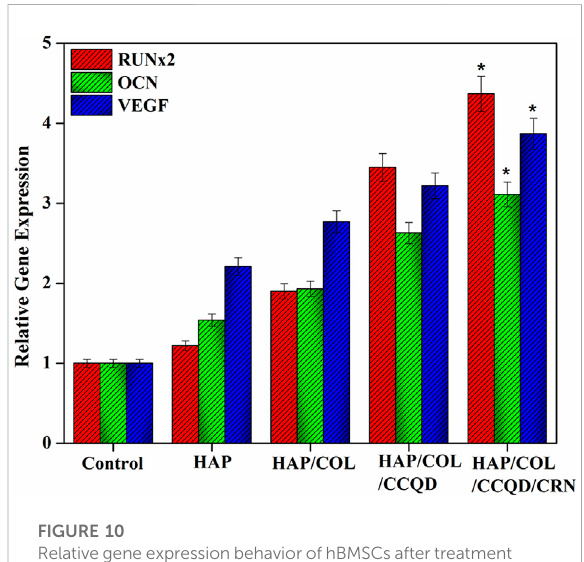
FIGURE 10 Relativegene expression behaviorofhBMSCs aftertreatment with (A) pureHAPceramic (B) HAP/COLcomposite, (C) HAP/COL/ CCQD composite, and (D) HAP/COL/CCQD/CRN composite 14 days of post culturing period. * p < 0.05 comparison of the experimented group with the control